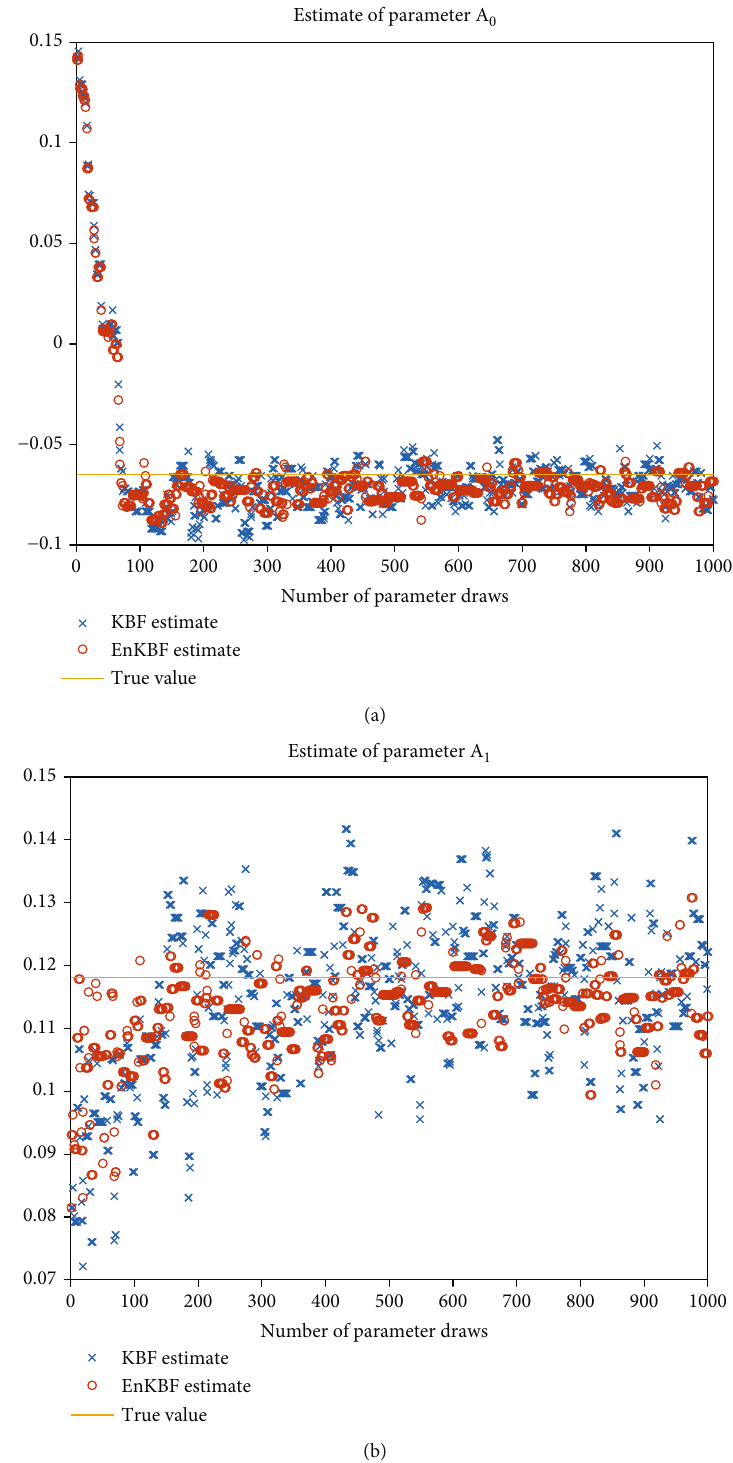
Figure 3: Plots for velocity parameters for the fi rst three parameters in λ obtained using KBF and EnKBF and run for 1000 time steps and for 1000 Metropolis-Hastings cycles. The number of particles used for EnKBF is M = 1000 , the time step size used in both fi lters is dt = 0 : 01 , μ = 0 : 001 , and 100 grid points are used. The plots indicate that the estimates, for both fi lters, converge after about 100